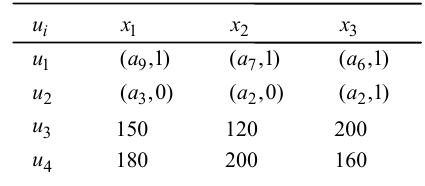
Table 4. Preference information given by 3 d